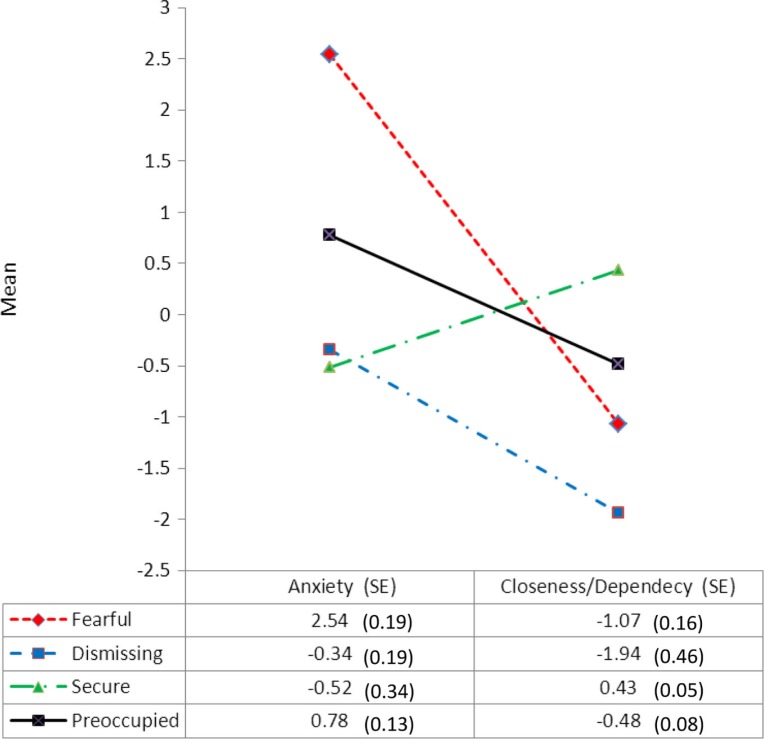
Four-class LPA plot with estimated means and probability scale (SE).